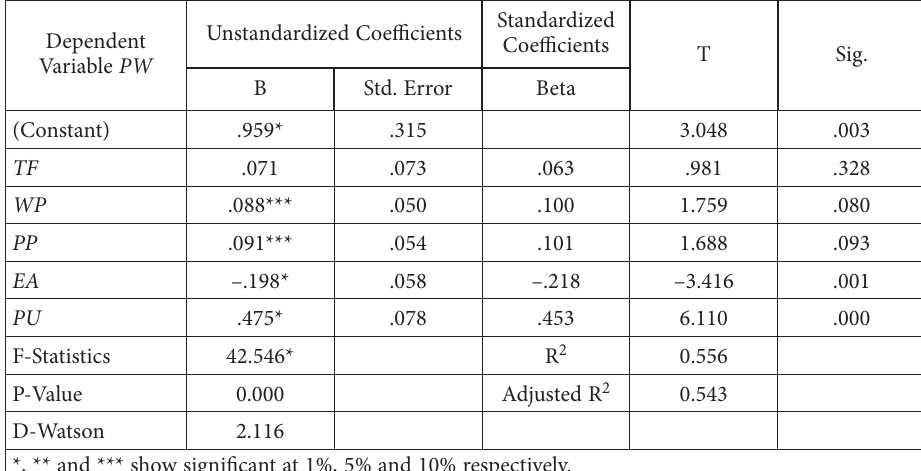
Table 6. Regression Model